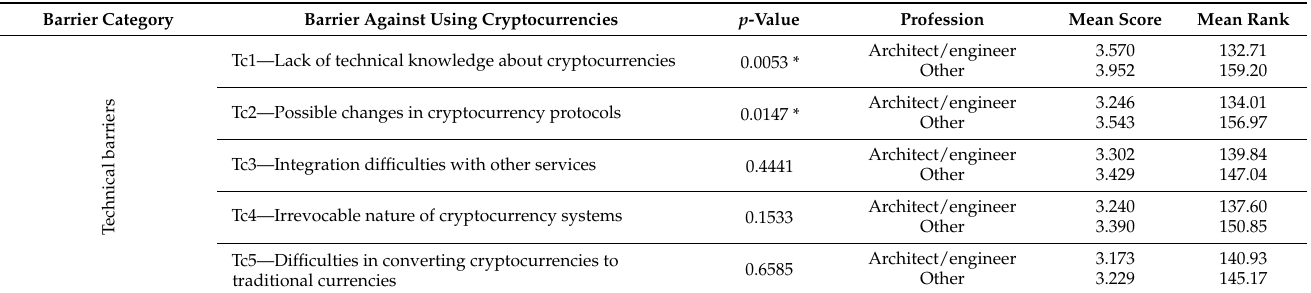
Table 6. Results of Mann–Whitney U test based on respondents’